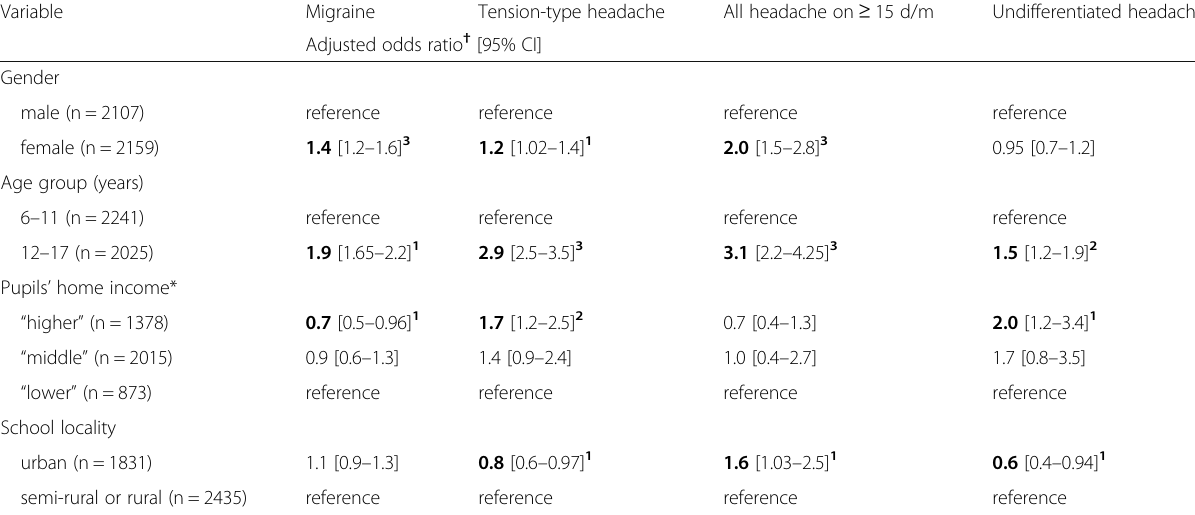
Table 4 Binary logistic regression analysis of associations of headache types with demographic variables (N = 4266)